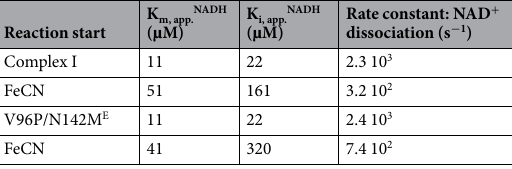
Table 1. Kinetic parameters of the NADH:ferricyanide oxidoreductase activity catalysed by the oxidised and the reduced E. coli complex I and the V96P/N142M E variant, respectively, derived from the data shown in Figs. S2 and